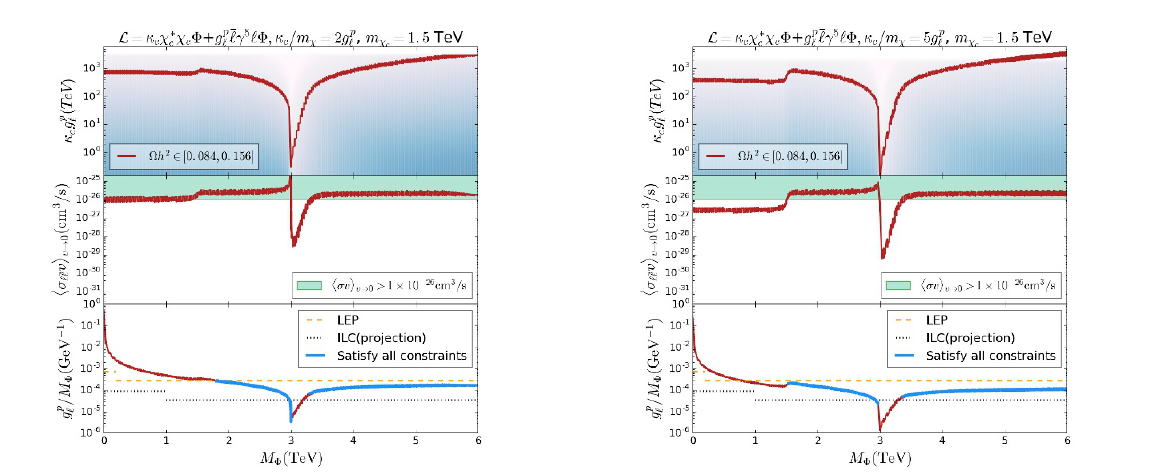
Figure 4 . A scalar mediator scalar coupled to complex scalar DM and pseudoscalar coupled to leptons with (cid:20) c =m (cid:31) = 2 g p (left) or (cid:20) c =m (cid:31) = 5 g p (right). Each panel shows DM properties as a ‘ ‘ function of mediator mass. The blue color gradient in the (cid:12)rst panel shows relic density, where darker blue means greater relic